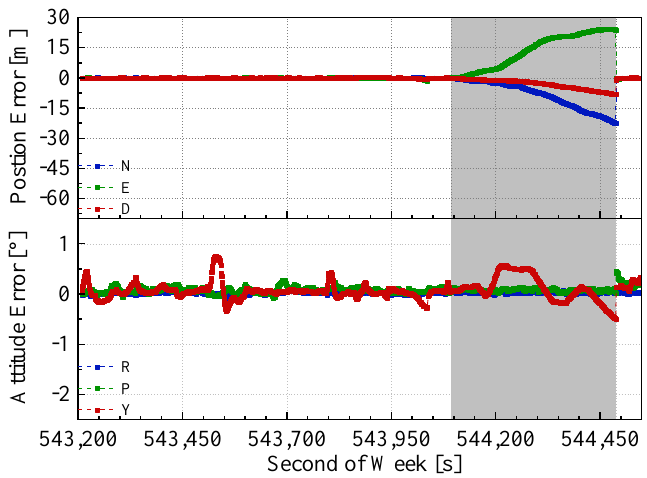
Figure 12. GNSS/INS/ODO navigation errors in the East Lake Tunnel test.